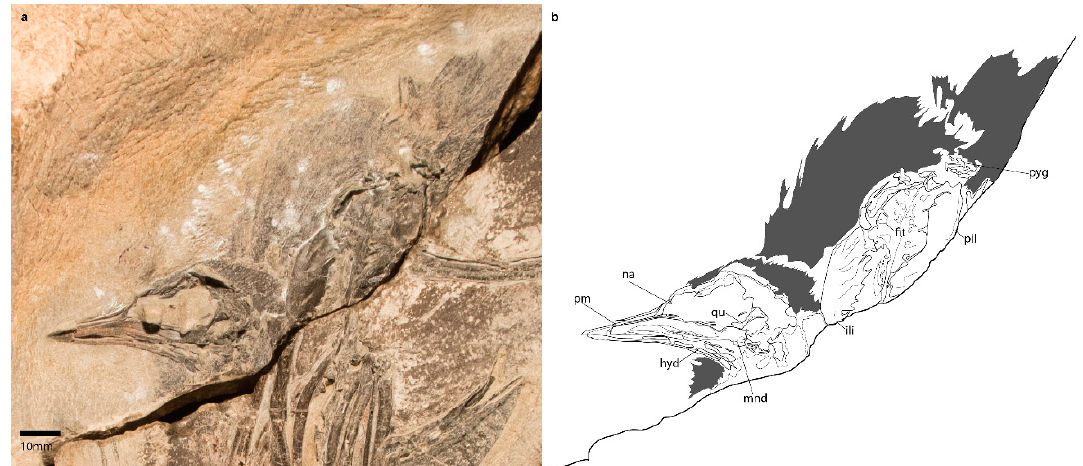
Figure 1. Photograph ( a ) and line drawing ( b ) of the holotype specimen of Pellornis mikkelseni , MGUH 29278. Soft tissue and plumage is filled in with gray. Dashed borders indicate bone that is extremely broken. Anatomical abbreviations: pm premaxilla, na narial bar, pal palatines, qu quadrate, mnd mandible, hyd hyoids, ili preacetabular ilium, pil postacetabular ilium, fit foramen intertransversarium, pyg pygostyle.